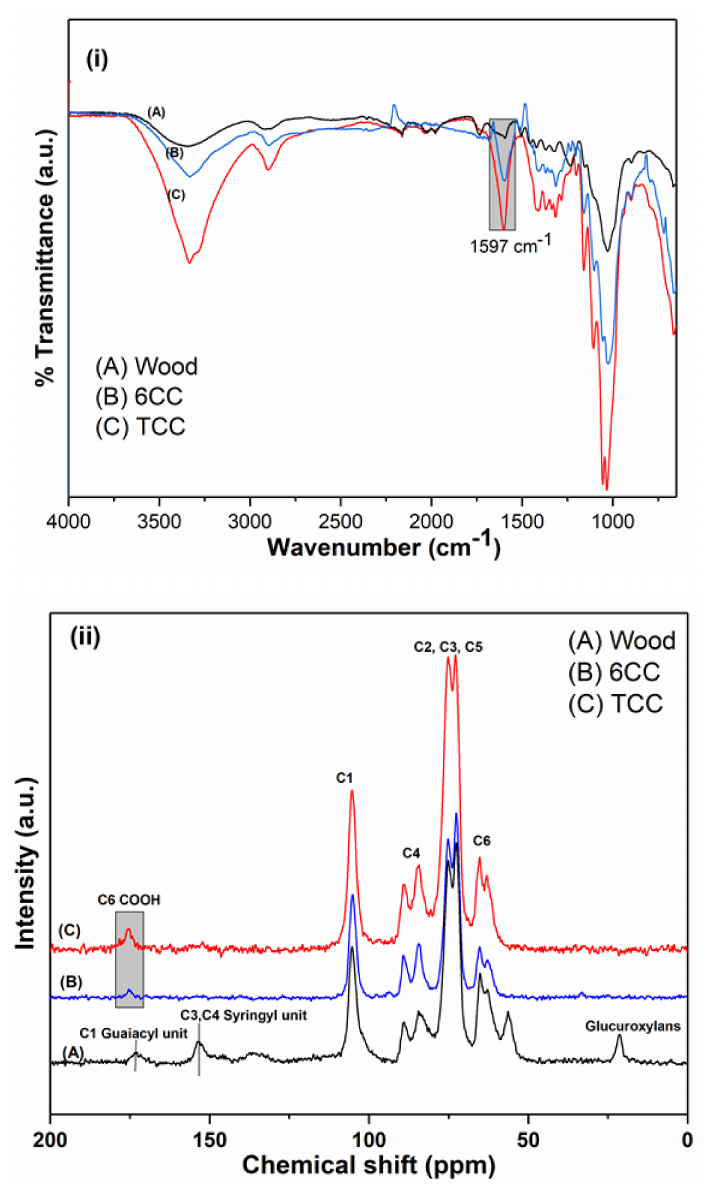
Figure 2. ( i ) FTIR of wood, 6CC and TCC; ( ii ) 13 C CPMAS NMR of wood, 6CC and